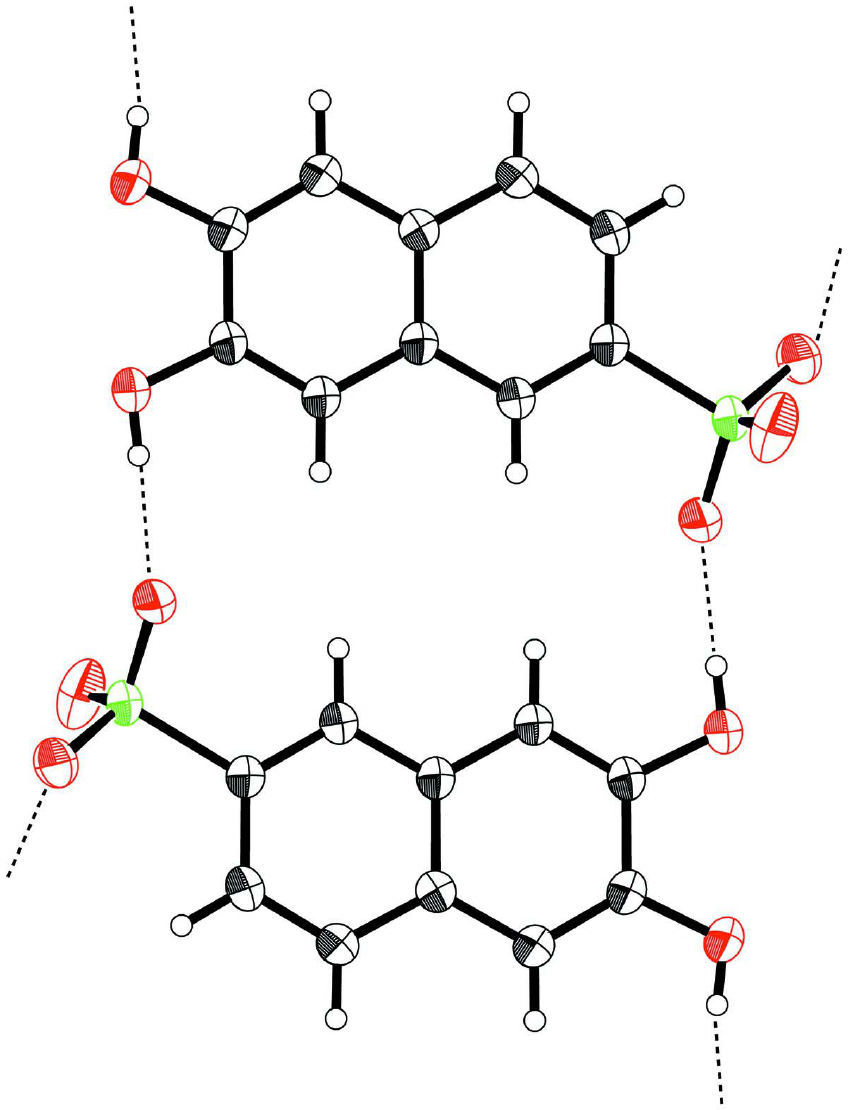
Figure 2 Hydrogen-bonded dimer unit A: (top view). The molecules are related by the symmetry operation (1–x, 2–y,